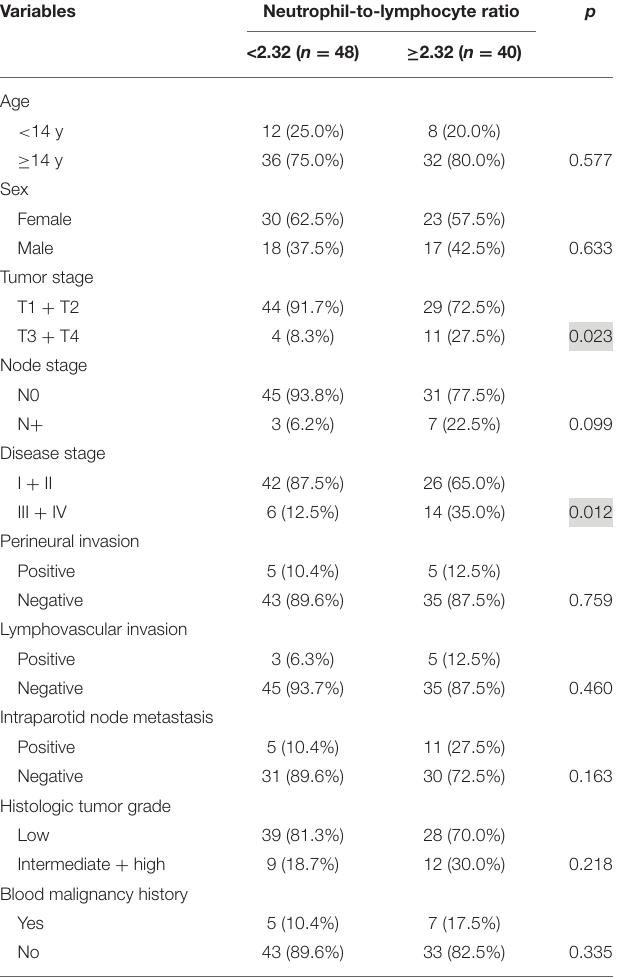
TABLE 1 | Association between neutrophil-to-lymphocyte ratio and clinical pathologic variables. Variables